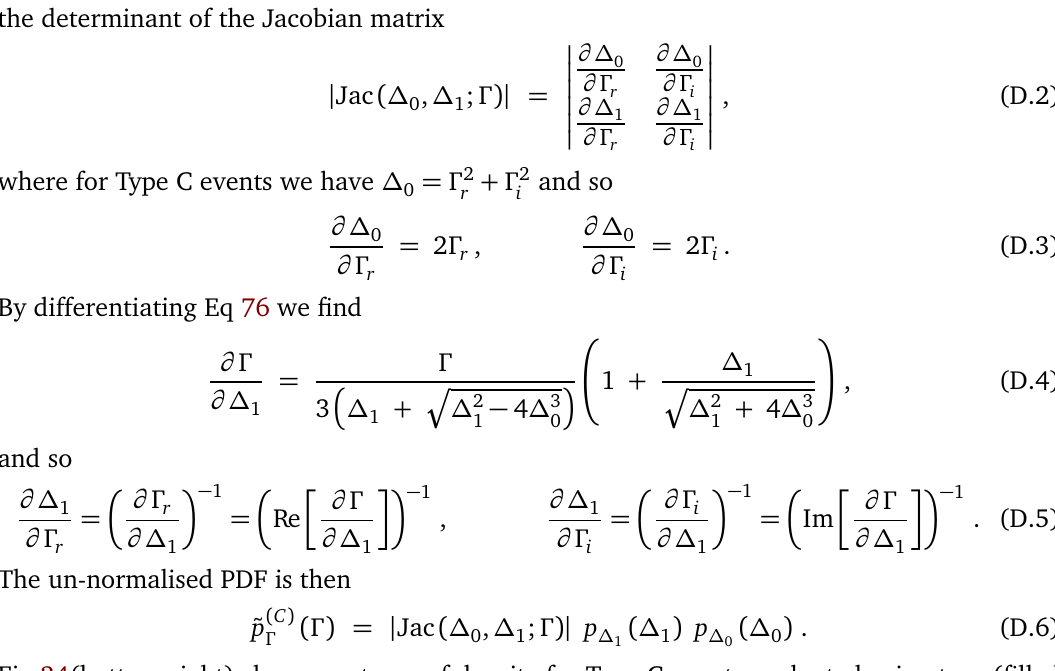
Fig 24(bottom right) shows contours of density for Type C events evaluated using toys (filled blue) and using our formula (red lines). Good agreement is